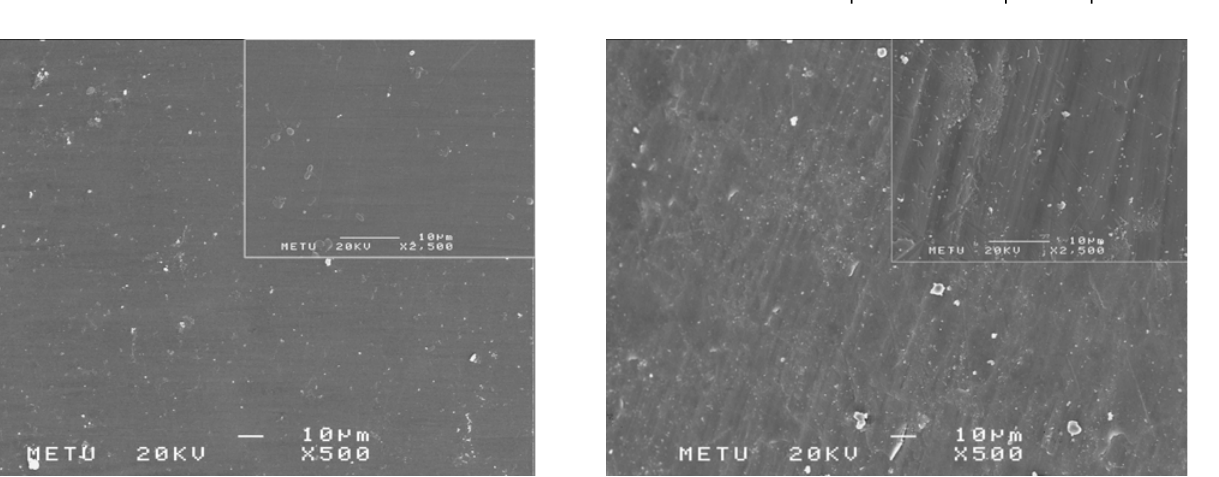
FIGURE 7- SEM analysis showing enamel surface after using 30-fluted tungsten carbide bur in combination with diamond coated one-step Po-Go micro-polisher point